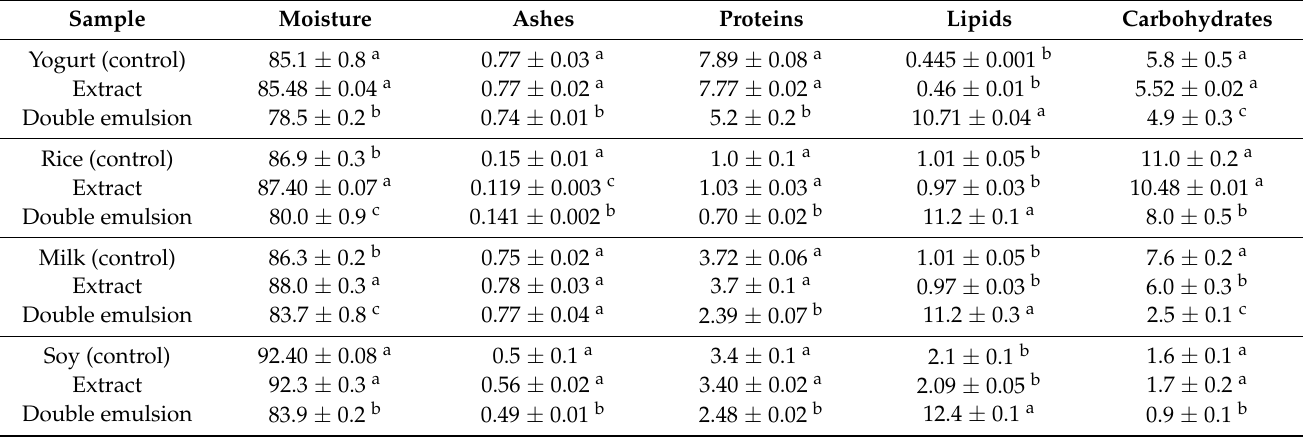
Table 4. Proximal composition of the base drinks (Yogurt, Rice, Milk, and Soy) and corresponding colored counterparts added with extract (Extract) and double emulsion (Double Emulsion). The values are expressed in g/100 mL.